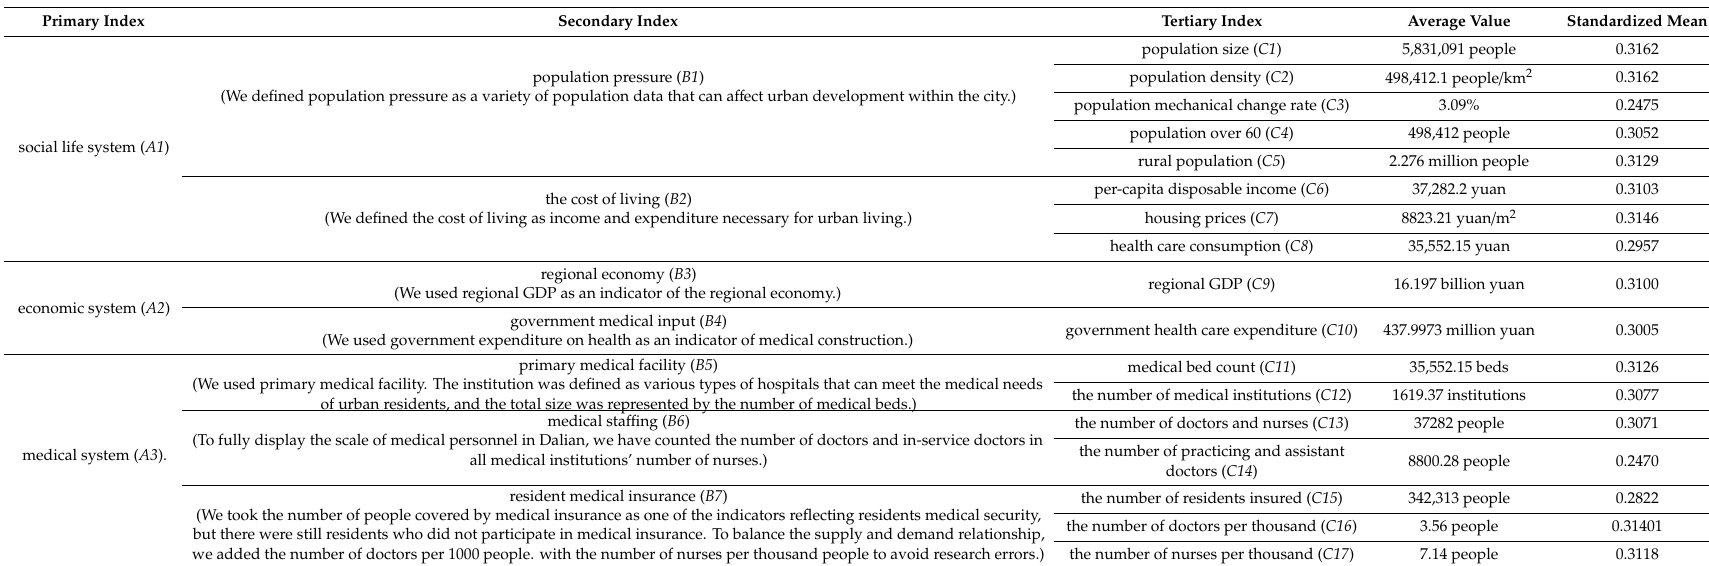
Table 1. Regional medical evaluation